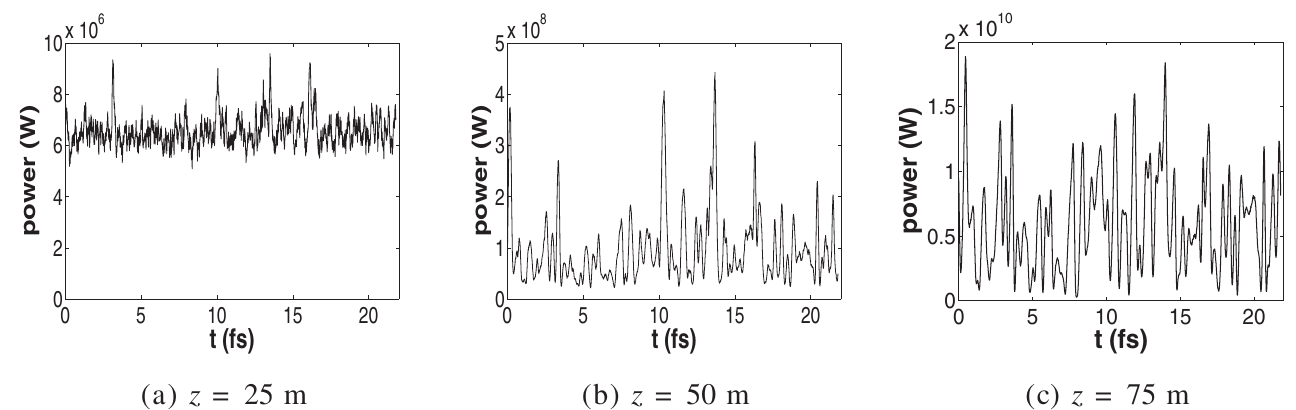
FIG. 10. Temporal structures of 10% of the LCLS pulse at different z